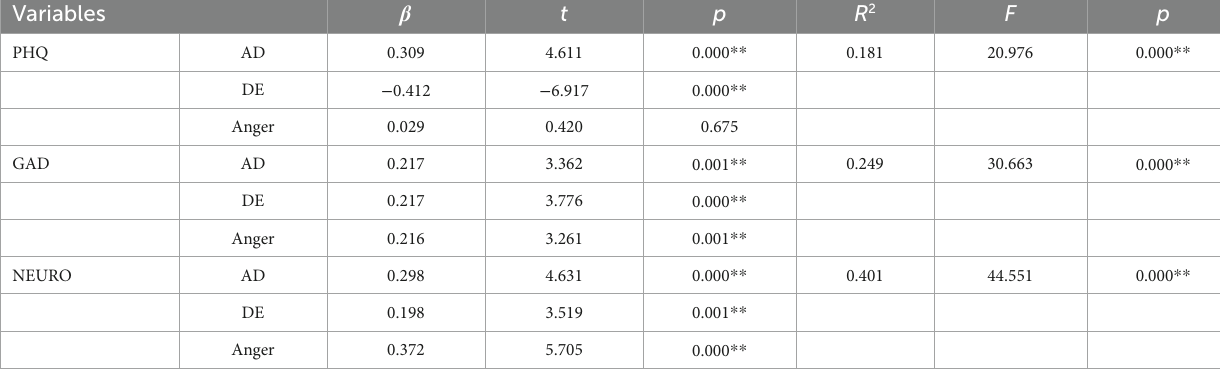
TABLE 5 Multiple linear regression analyses on the effect of AD, Anger, and DE on PHQ, GAD, and NEUROTICISM.